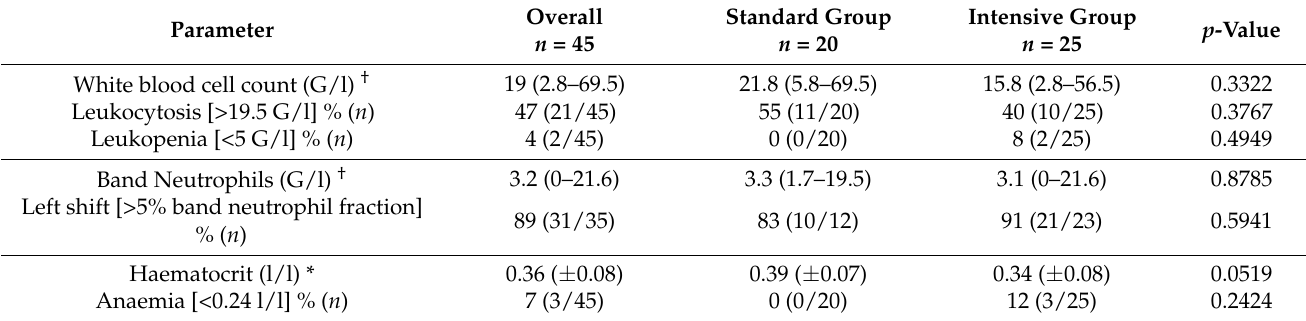
Table 3. Laboratory